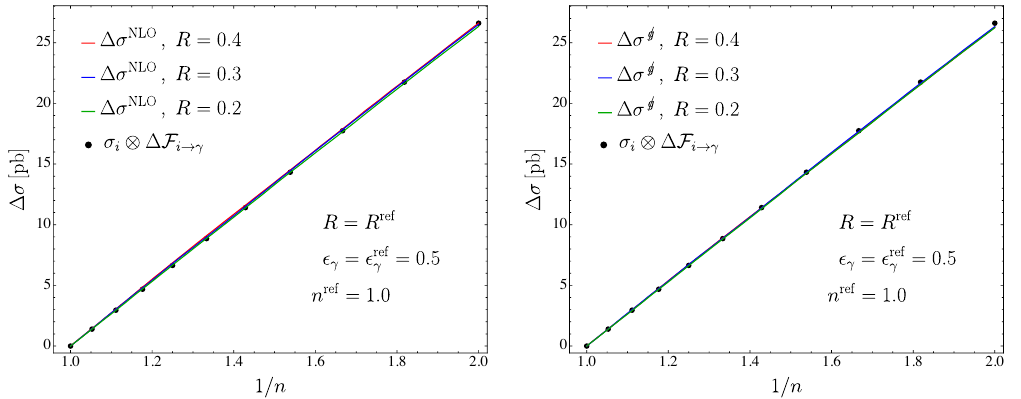
Figure 5 . Dependence of ∆ σ on the value of the parameter n of the smooth-cone isolation (1.2). The lines labeled ∆ σ NLO are the difference of the full NLO cross sections. For the lines labeled ∆ σ g/ in the right plot gluons inside the isolation cones were vetoed. The dots represent ∆ σ = σ i ⊗ ∆ F i → γ computed with the fragmentation function according to (3.16) and is independent of R for R = R ref